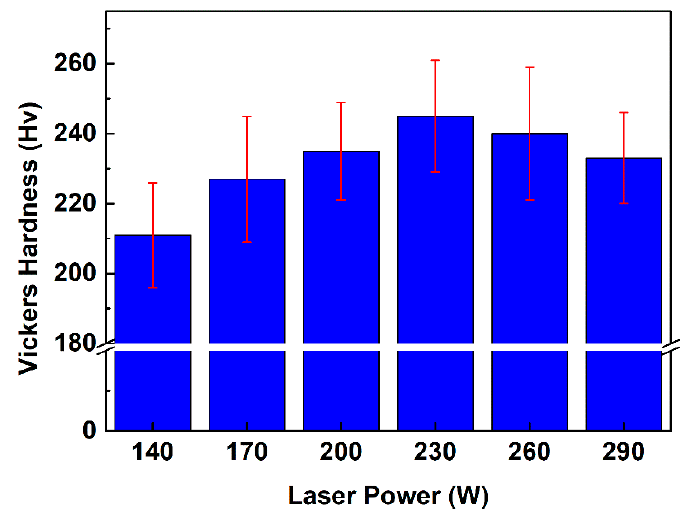
Figure 8. Vickers hardness of the 316L stainless steel samples manufactured by SLM.